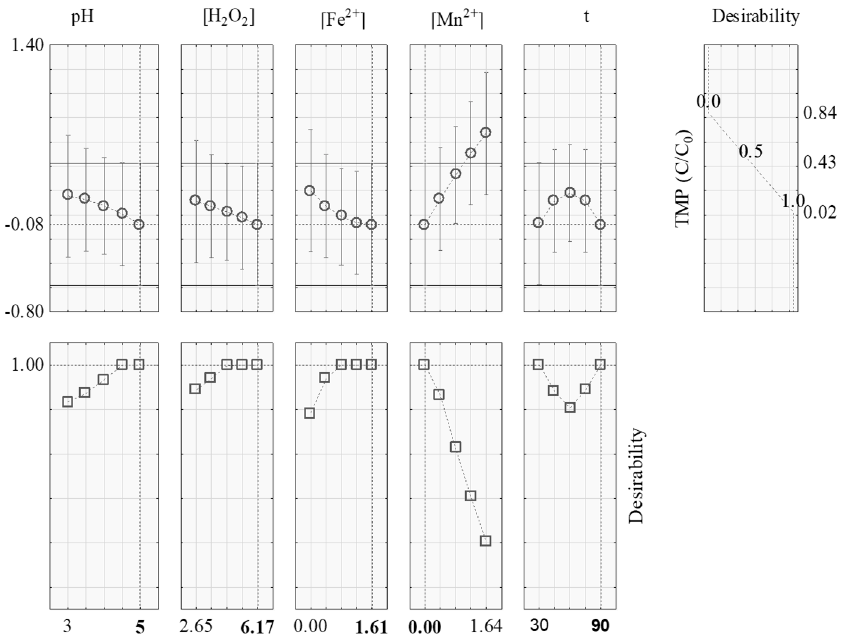
Figure 5. Profile of the predictive values and desirability function of the degradation of the emergent micropollutant TMP.